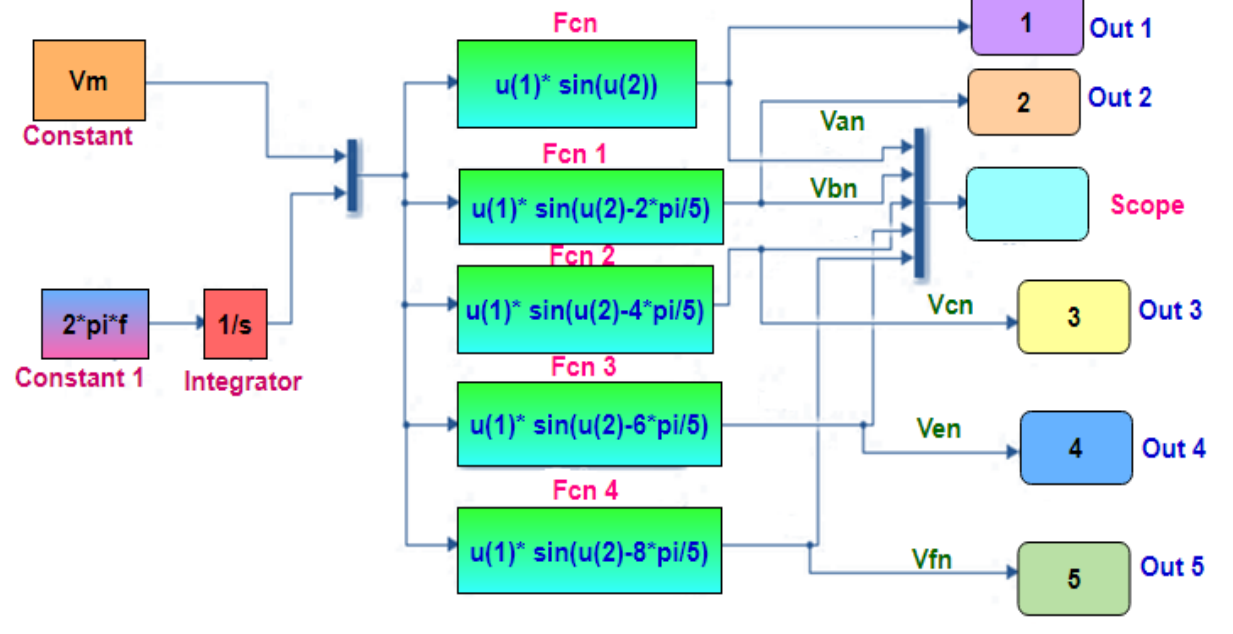
Figure 1. Modeling of five-phase inverter. Table 1. Switching states of five-phase inverter for phase